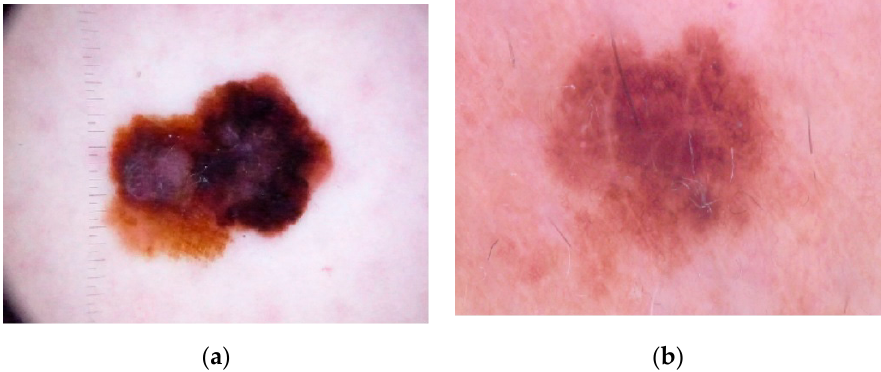
Figure 1. Images of melanoma and nevus tissues: ( a ) Skin lesion from melanoma image; ( b ) Nevus Skin.